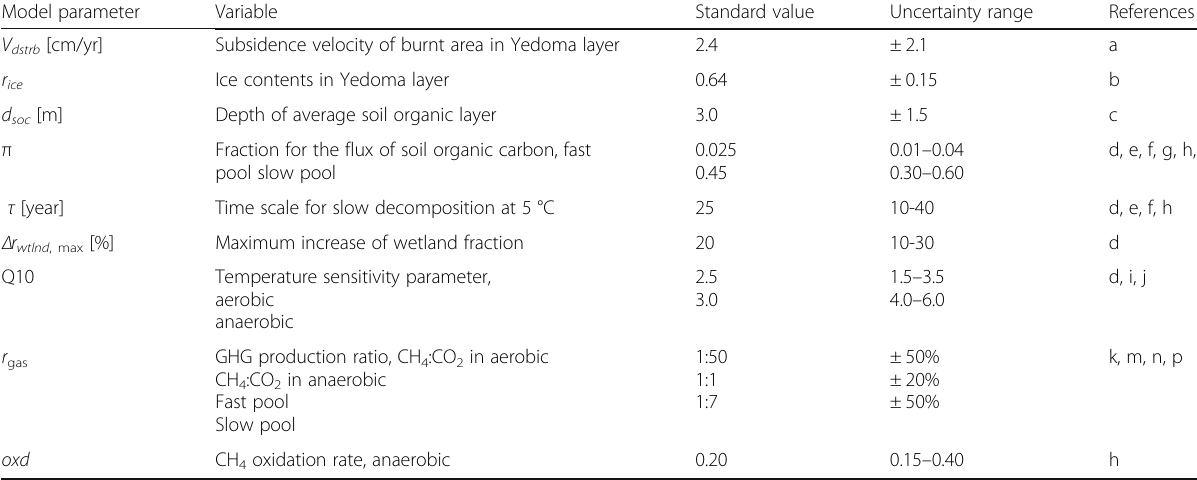
Table 1 Model parameters for the calculation of GHG emissions due to the dynamic and thermodynamic permafrost degradations Model